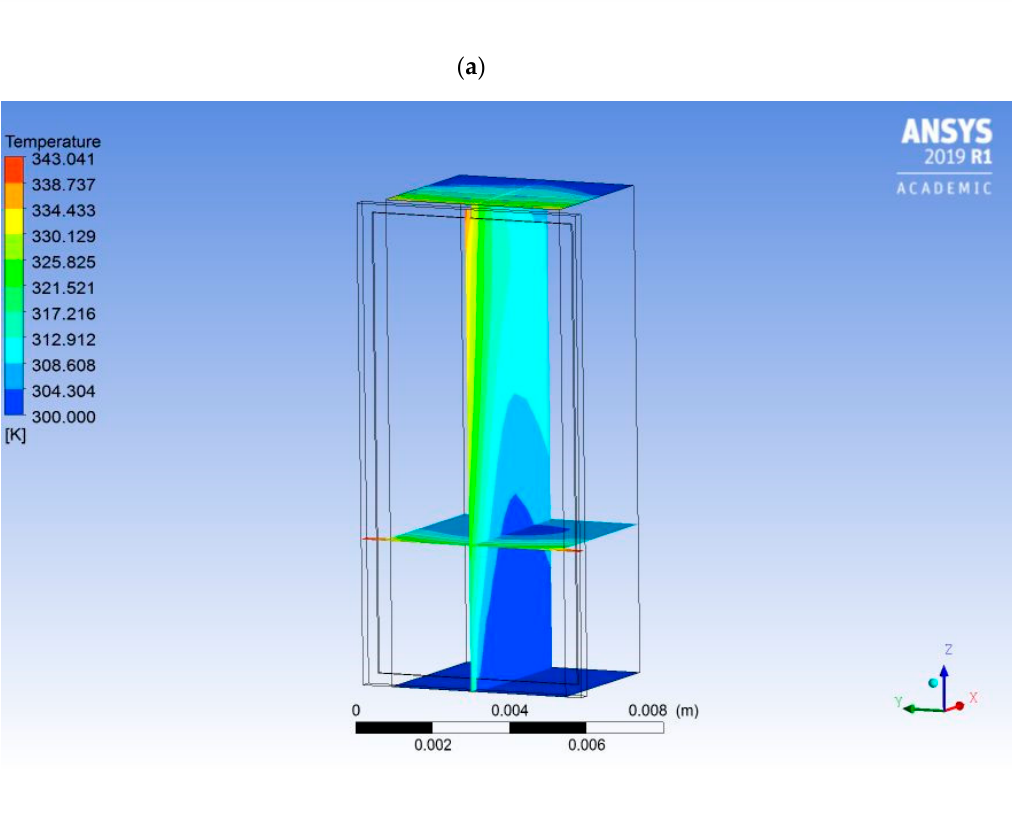
Figure 7. ( a ) Simulated temperature contours on the surface of the PV panel, Duct-2, 45 cm width; ( b ) simulated temperature contours across the duct width behind the PV panel, Duct-2, 45 cm width.